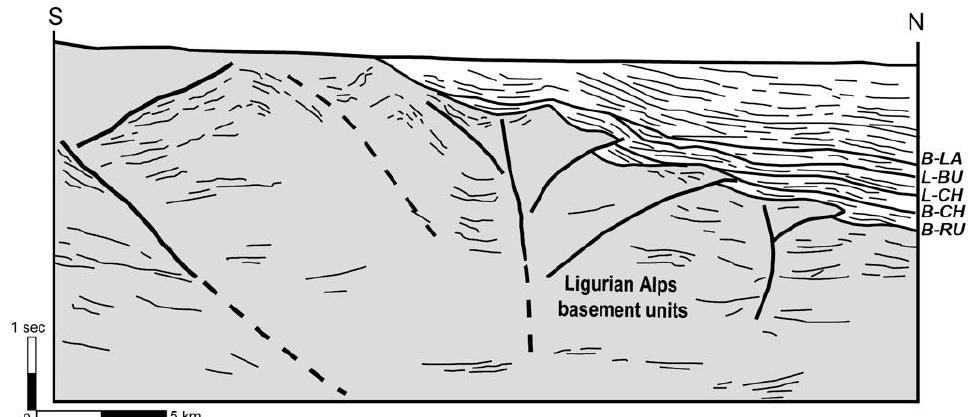
Figure 9. Seismic line drawing crossing the TPB sediments in the subsurface of the Cuneo-Mondovì area. The unconformities are base Rupelian (B-RU), base Chattian (B-CH), late Chattian (L-CH), late Burdigalian (L-BU) and base Langhian (B-LA). From [7,65].